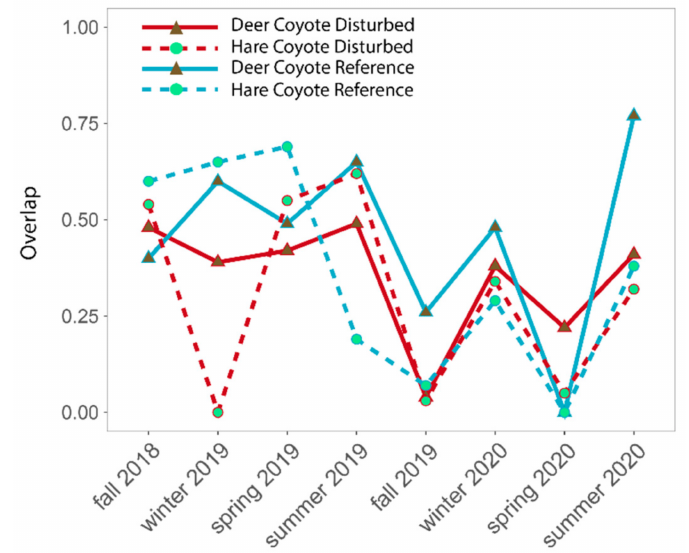
Figure 6. Summary of activity between deer and coyote and hare and coyote seasonally from fall 2018 to summer 2020 for the reference and disturbed forest conditions. Values correspond to overlap percentages in Figure